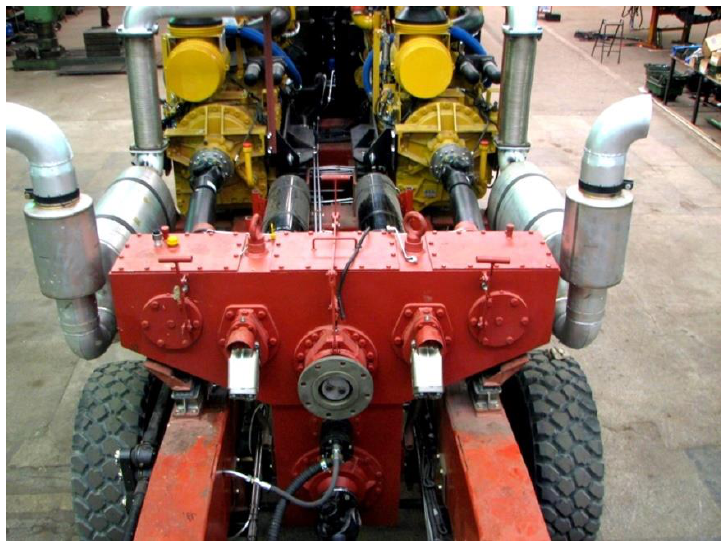
Figure 2. The adder and distribution box.